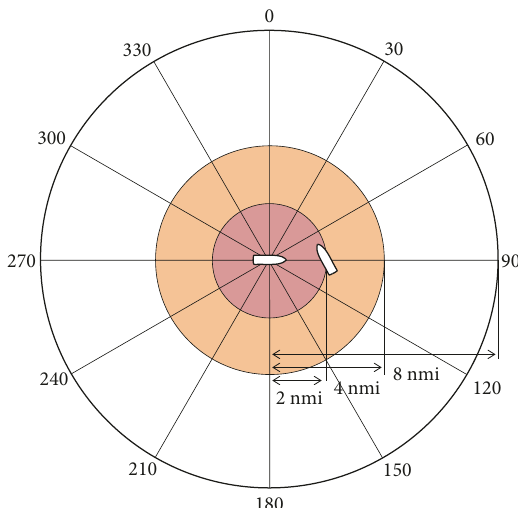
Figure 2: Resulting simulation model with ships in a heavy traffic